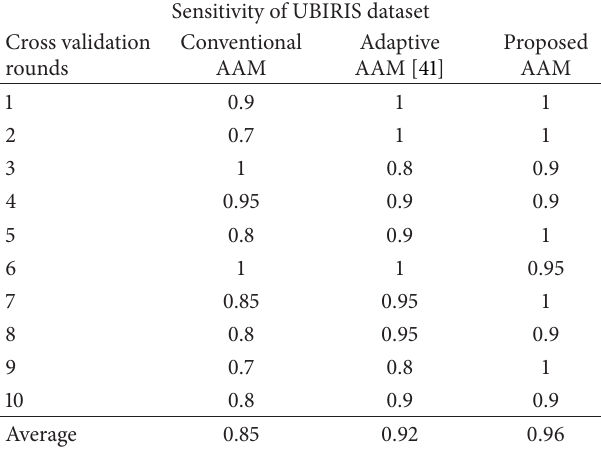
Table 10: Cross validation results for 2.5D dataset in terms of specificity for conventional AAM, adaptive AAM, and the proposed